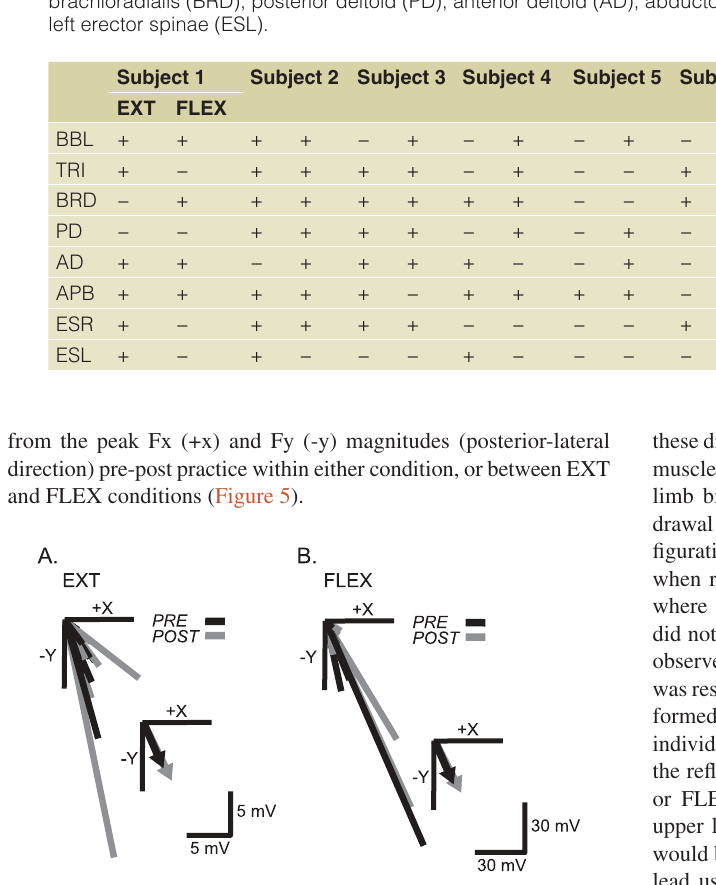
Figure 5. Group endpoint force vectors from the Fx (+x) and Fy (-y) before (black) and after (grey) practice for each subject with the A) EXT practice, and the B) FLEX practice. The inset on each panel shows the average for all subjects. No significant differences were